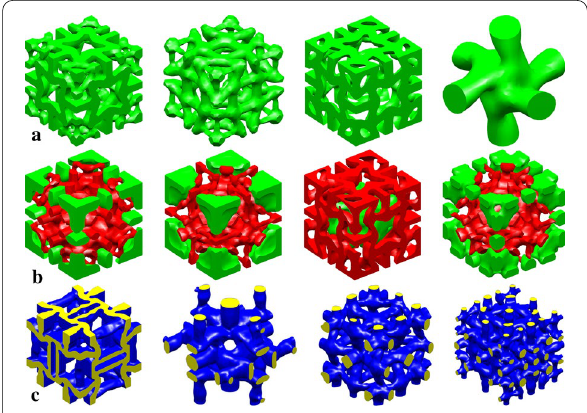
Figure 10 Some optimized design of auxetic microstructures